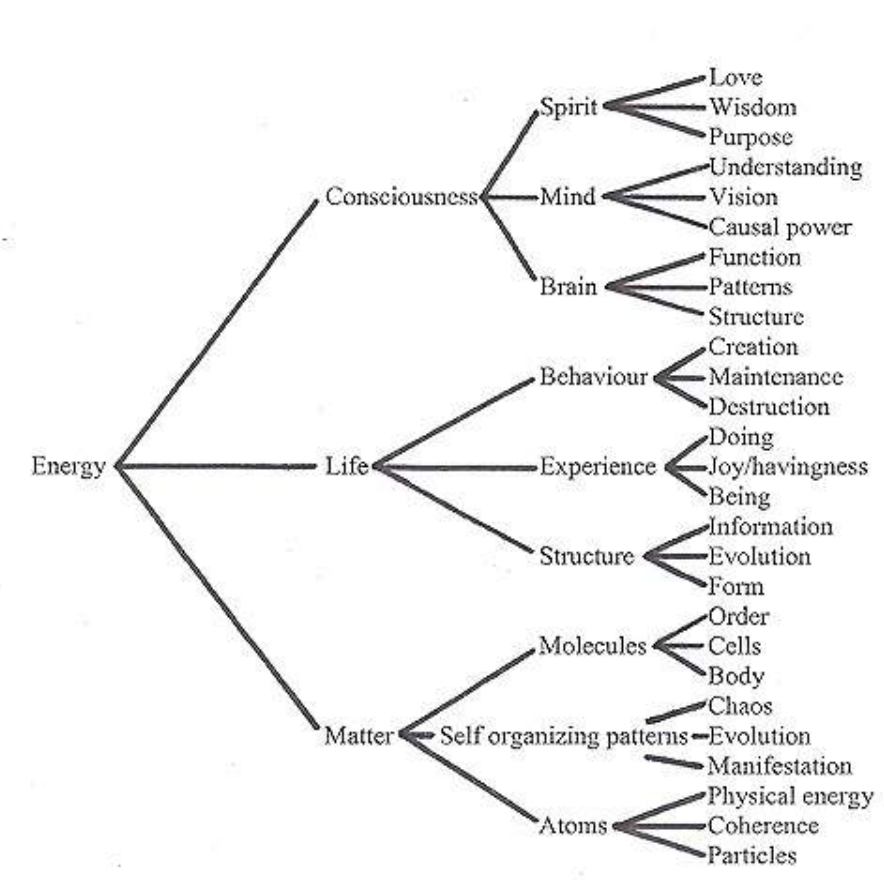
FIGURE 4. A fractal ontology with the bifurcation number 3. Please note that the concepts invited by a higher bifurcation number have more depth, complexity, and more appeal to the consciousness. They are more relevant to psychology and existential philosophy than to the natural